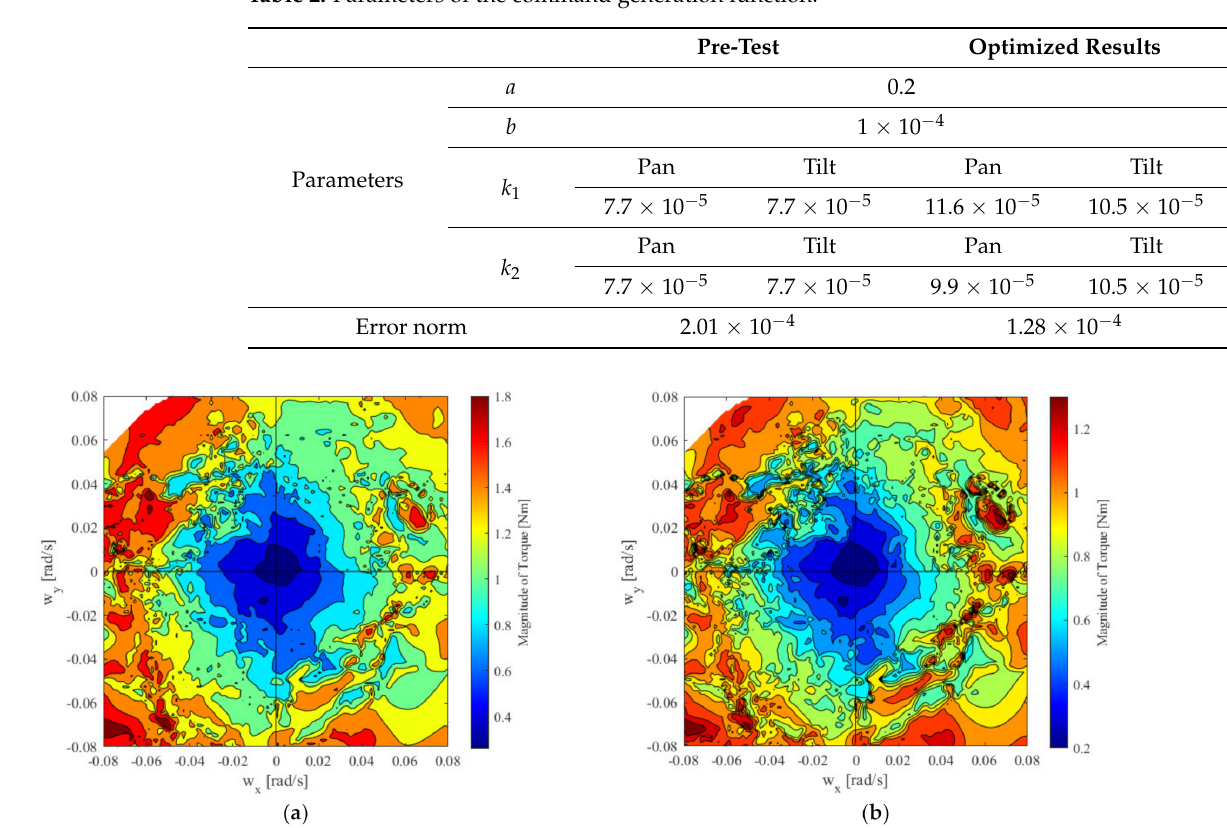
Figure 6. Contour of required torque for motion velocity: ( a ) pre-test; ( b ) optimized